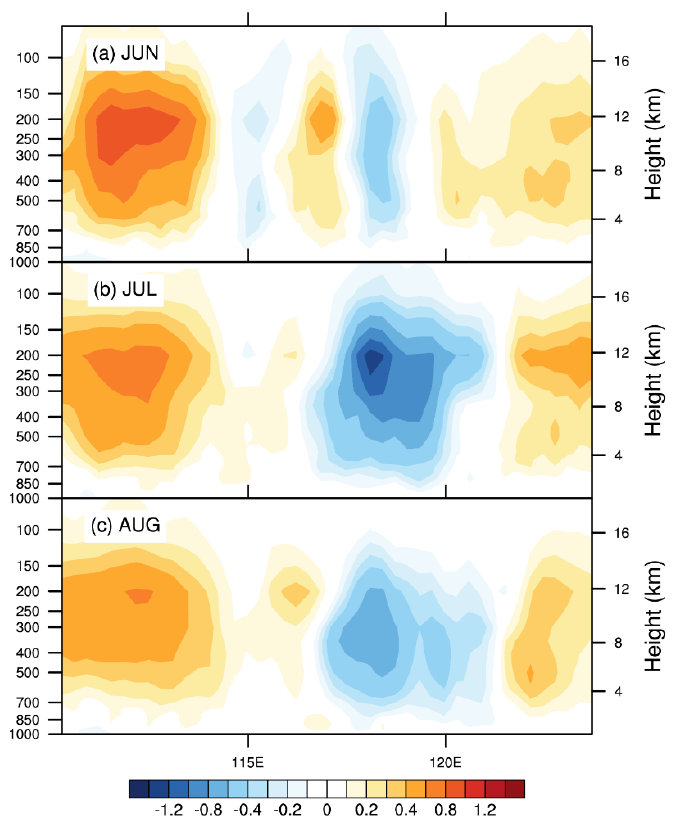
Figure 11. Monthly average difference due to ADE (CTL-SEN test) in the zonal mean vertical ve- locity (unit: m/s) over SC region on ( a ) June, ( b ) July, and ( c ) August. Left axis stands for pressure levels (unit: hPa) and right axis stands for the height (unit: km).